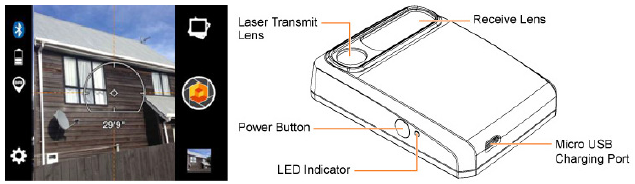
Figure 3. Spike – Ike. Laser accurate Smartphone measurement.